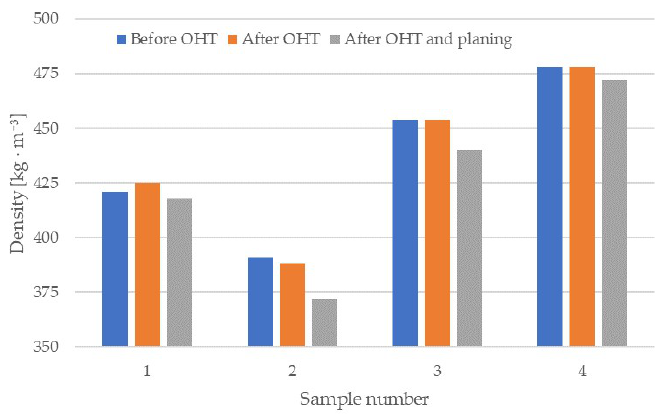
Figure 1. Wood density of the wedges in the different stages of the study.